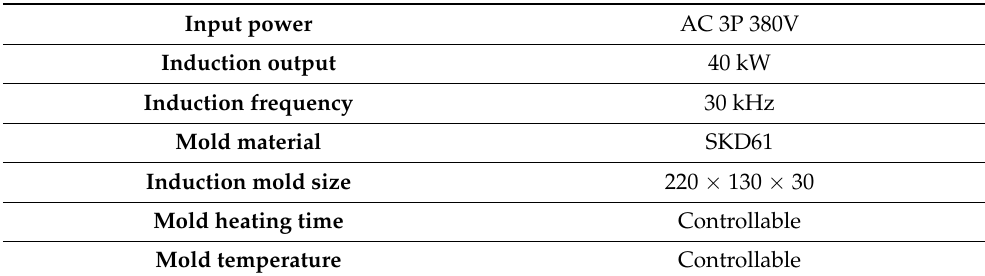
Table 5. Specifications of the induction